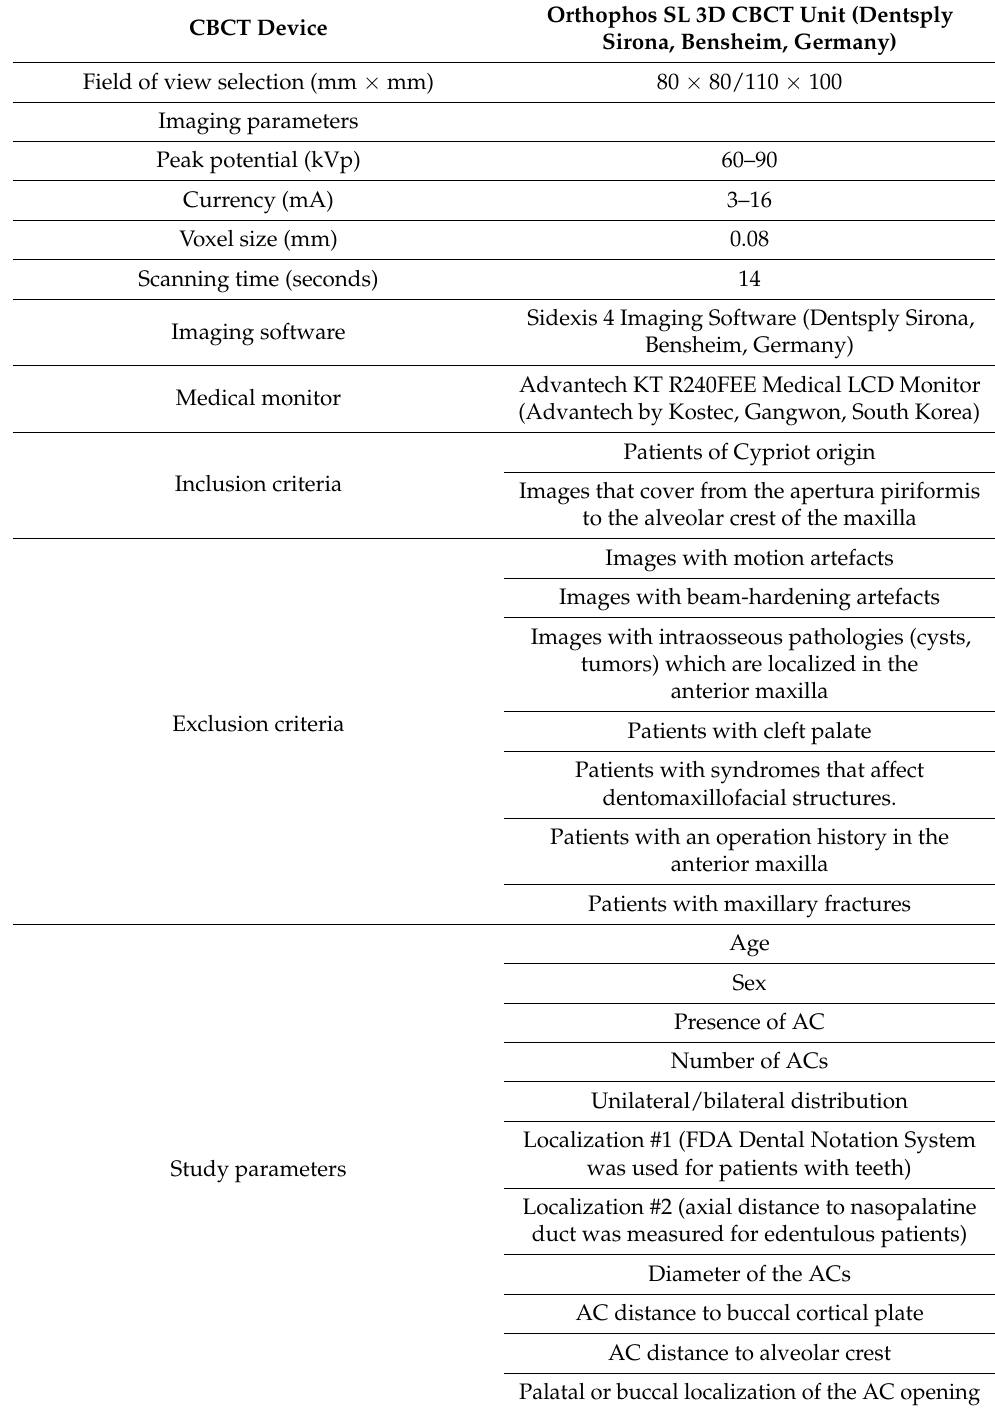
Table 1. Summary of the materials and parameters of the